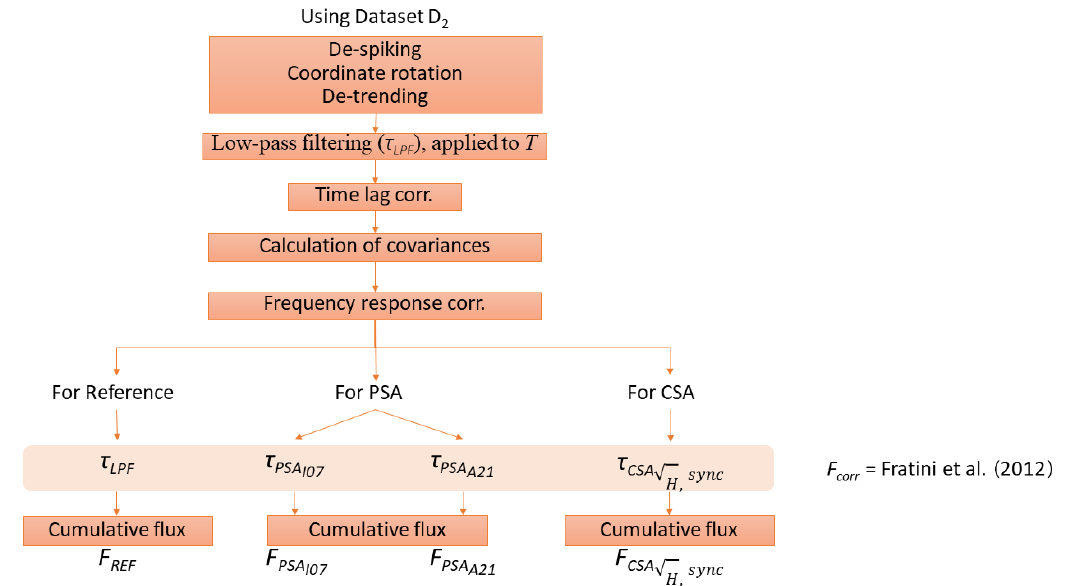
, F PSA , F CSA √ , and I07 A21 H, sync